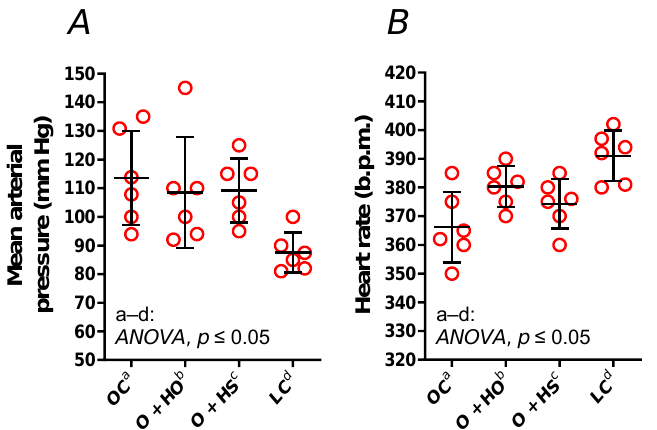
Figure 6. Mean arterial pressure ( A ) and a heart rate ( B ) of 8-week-old lean (LC) and obese (OC) Zucker rats fed a diet containing hemp seed oil (HO) and hemp seeds (HS) for 4 weeks. Values are means ± SD, n = 6, p ≤ 0.05 (two-way ANOVA). HO and HS had no impact on mean arterial pressure and heart rate.